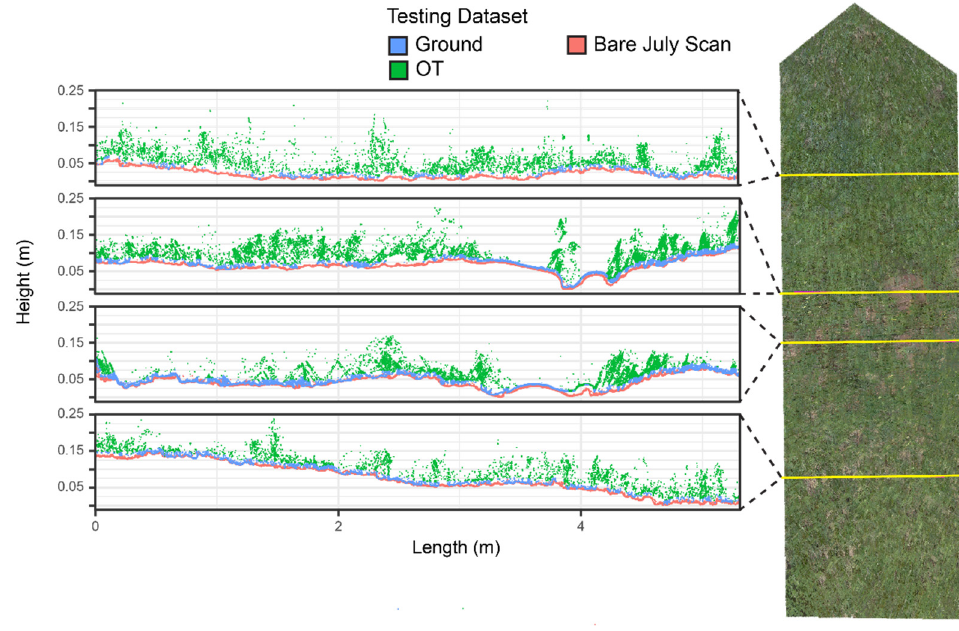
Figure 7. Plot cross sections showing classified testing dataset points and bare July 3D point cloud.